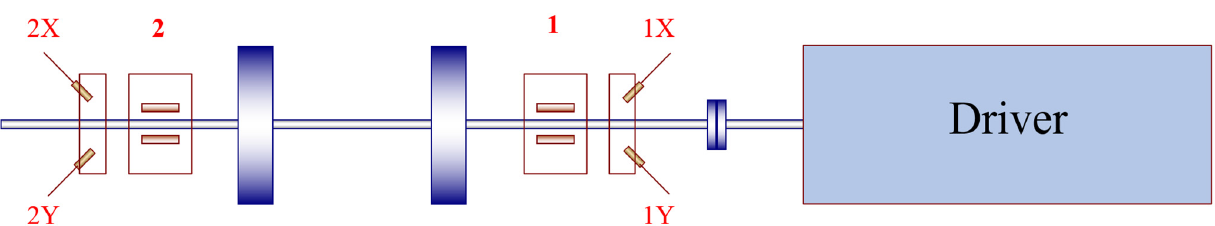
Figure 5. Scheme of the model used for